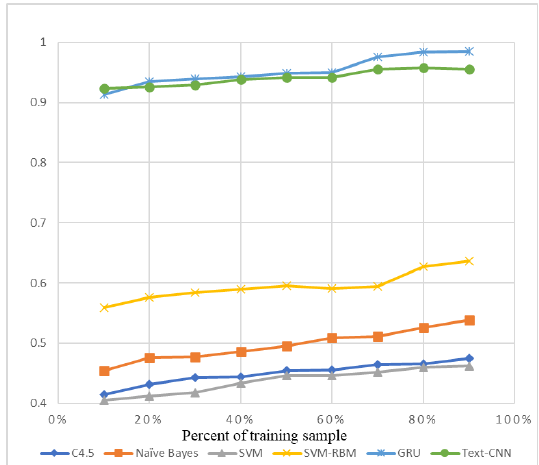
Figure 10. F1-score of KDD99-R2L.